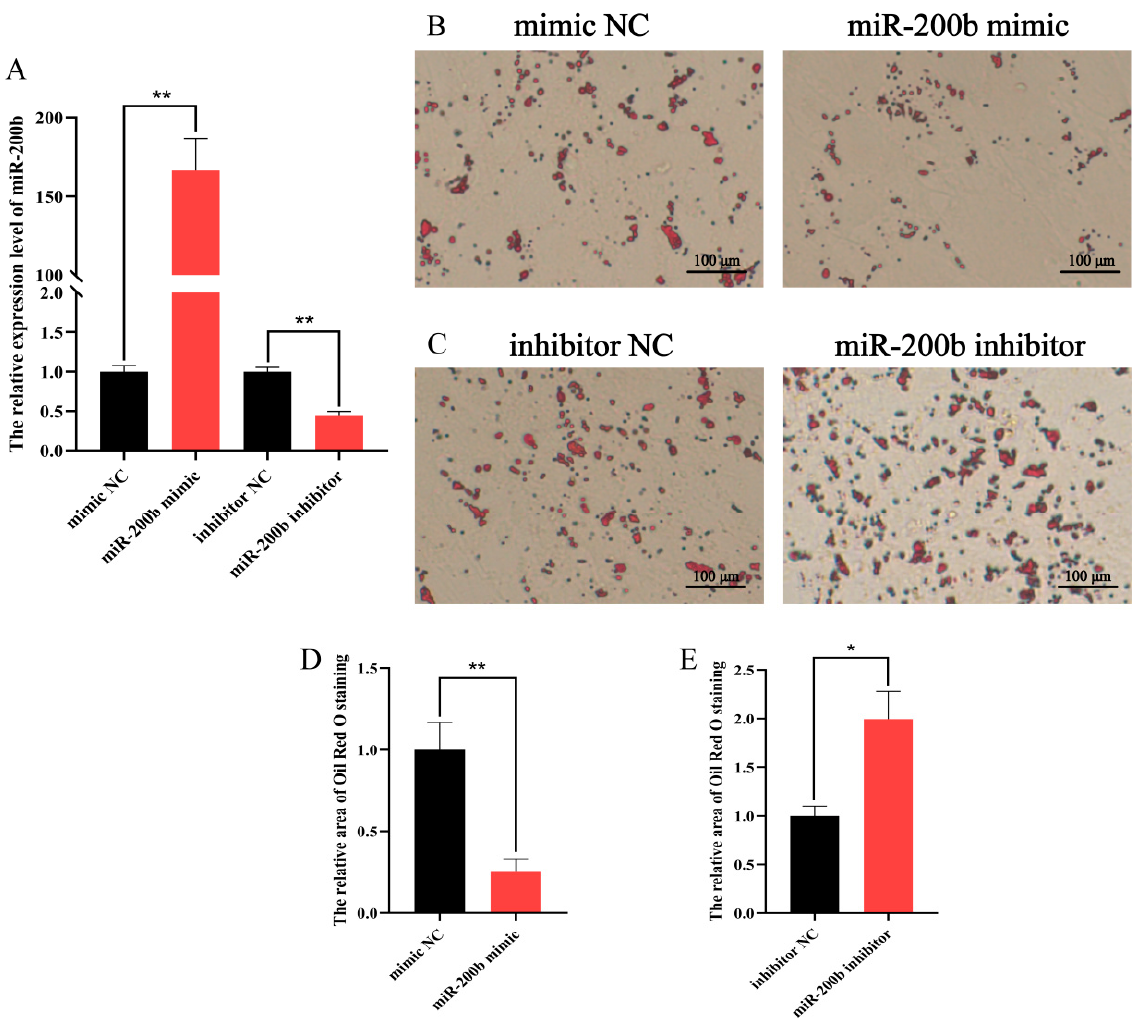
Figure 4. The effect of miR ‐ 200b on ovine adipocyte differentiation on day 8 after transfection with miR ‐ 200b mimic, miR ‐ 200b inhibitor and negative control (NC). ( A ) The transfection efficiency of miR ‐ 200b. ( B , C ) The Oil Red O staining results of ovine adipocytes. ( D , E ) The area of Oil Red O staining counted by the ImageJ software. The values represent mean ± SD ( n = 3), * p < 0.05, ** p < 0.01.